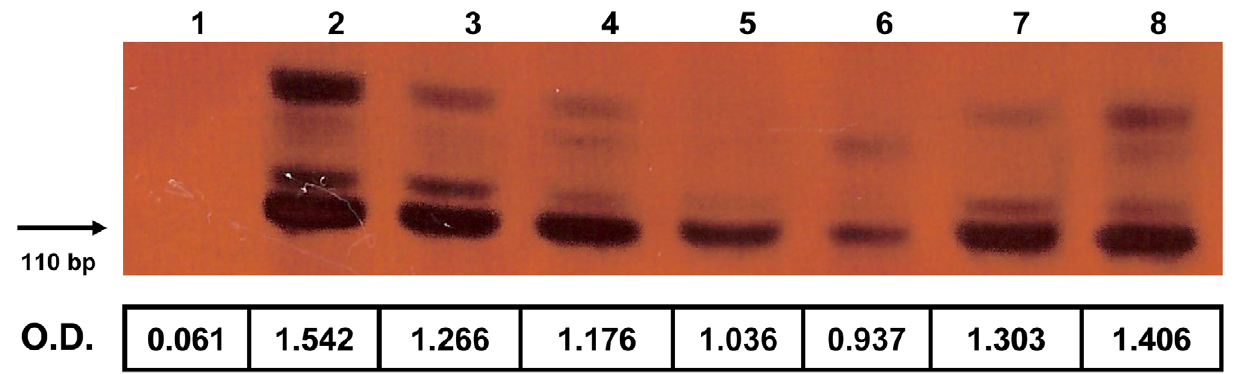
Figure 2. Analytical specificity of PCR followed by 6% polyacrylamide gel electrophoresis with silver staining and ELISA (optical density, OD) for purified DNA from adult S.magrebowiei (lane 2), S.rhodaini (lane 3), S.japonicum (lane 4), S.intercalatum (lane 5), S. haematobium (lane 6), S.bovis (lane 7) and S.mansoni (lane 8) worms. Lane 1, PCR negative control. The genus specificity of the Schistosoma PCR-ELISA system was demonstrated by the amplification of the 121-bp tandem repeat DNA sequence in all samples with the same set of primers. Absorbance readings were also consistent with the positive control ( S. mansoni DNA).